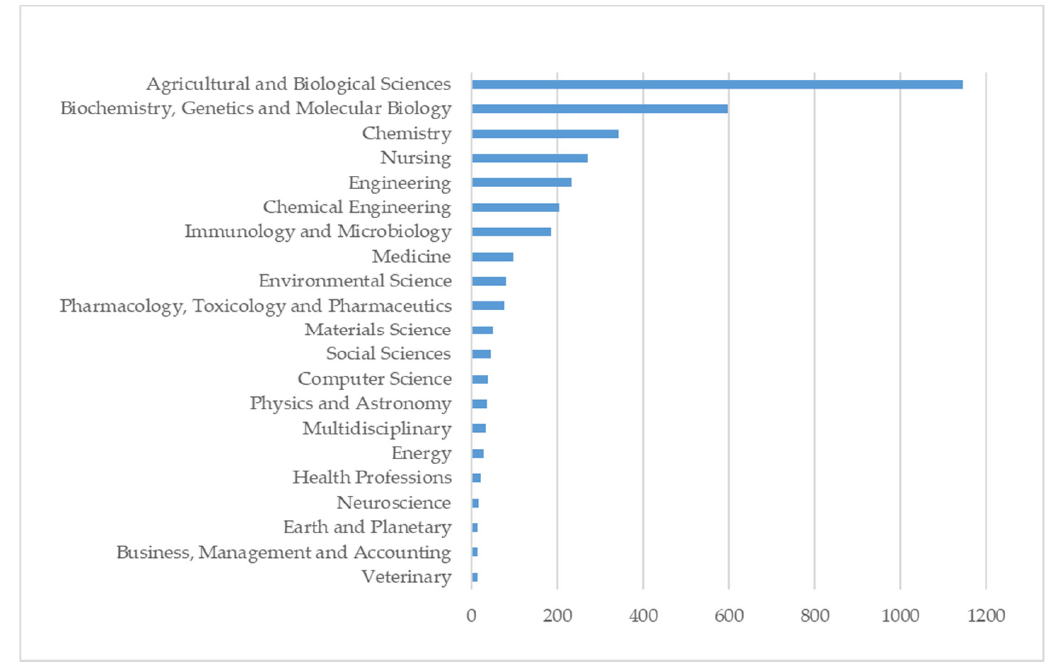
Figure 3. Subject area of the articles.